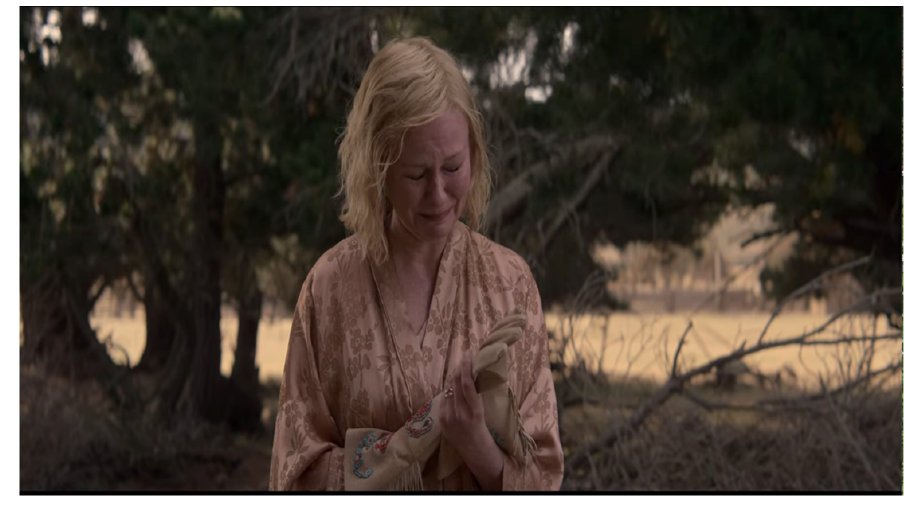
Figure 15. The Power of the Dog . Netflix.